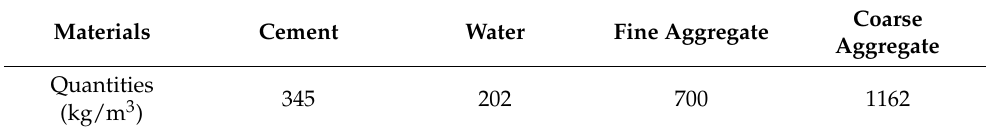
Table 2. Concrete mix